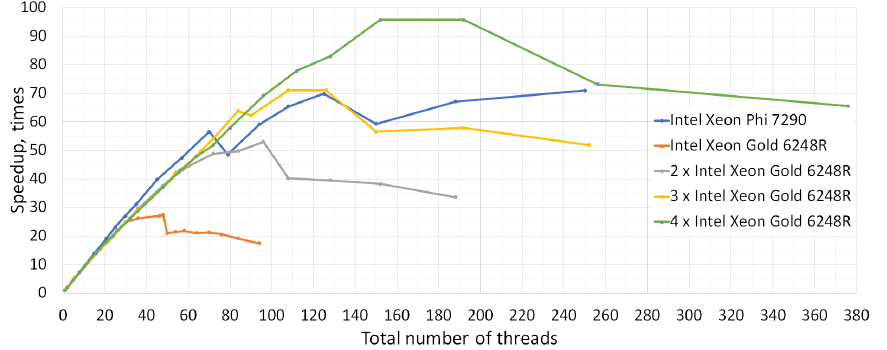
Figure 6. Speedup of sensitivity operator matrix construction on different hardware configurations. The best values are achieved with the numbers of threads equal to the number of processor cores (for Intel Xeon Phi node, triple the number of